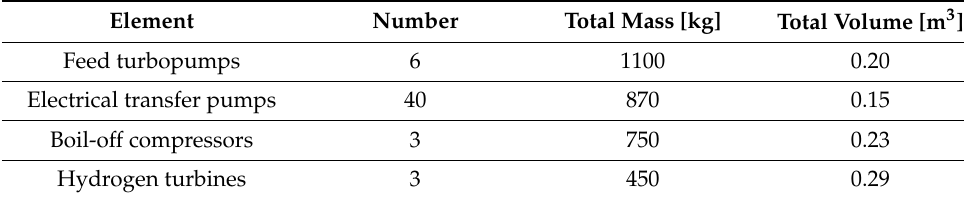
Table 3. Mass and volume breakdown for active elements of the